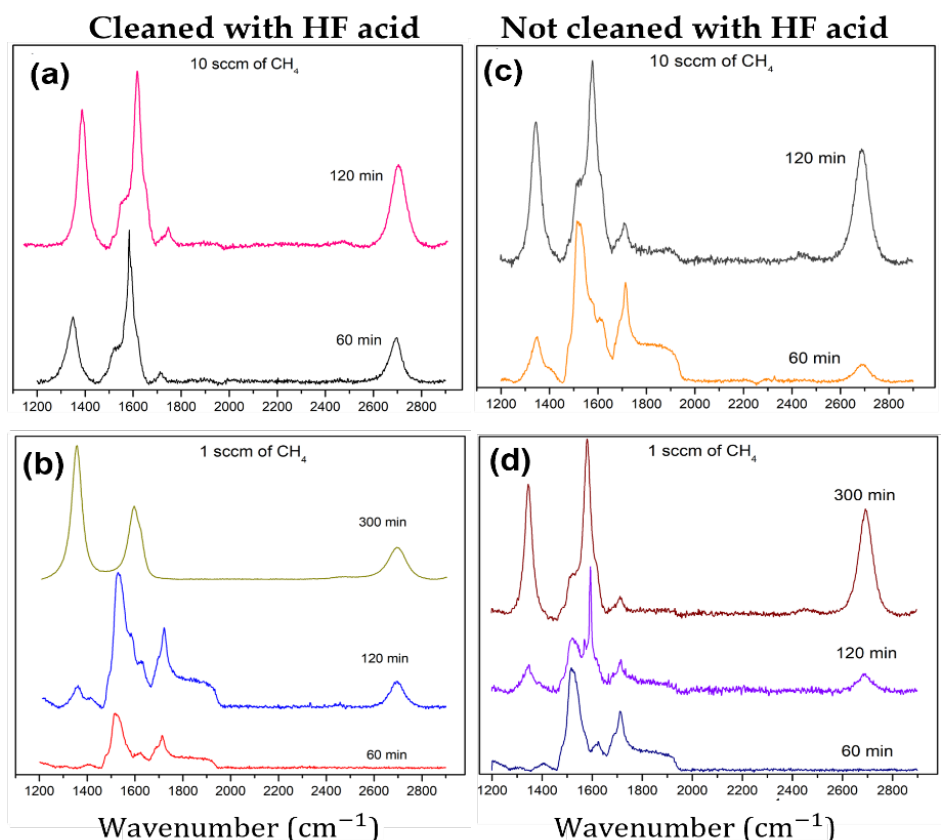
Figure 2. Raman spectra of graphene on SiC substrate: ( a , b ) represent the samples cleaned with HF and exposed to 10 and 1 sccm of CH 4 flow, respectively, and ( c , d ) correspond to samples at the same gas flow but without the HF cleaning process, respectively.